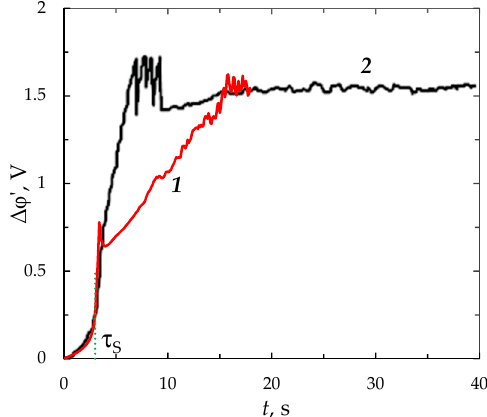
Figure 14. Calculated 1 for c 0 = 0.01 mol/m 3 ( ε = 1.53 × 10 − 9 ) and experimental 2 ChP for a MA-40-13 membrane in a 5 mol/m 3 NaCl solution ( ε = 3.06 × 10 − 12 ) at i/i lim = 3.6. The Sand ( τ s = 3 s) transition times is shown with vertical dotted lines. The experimental data are taken from [44].